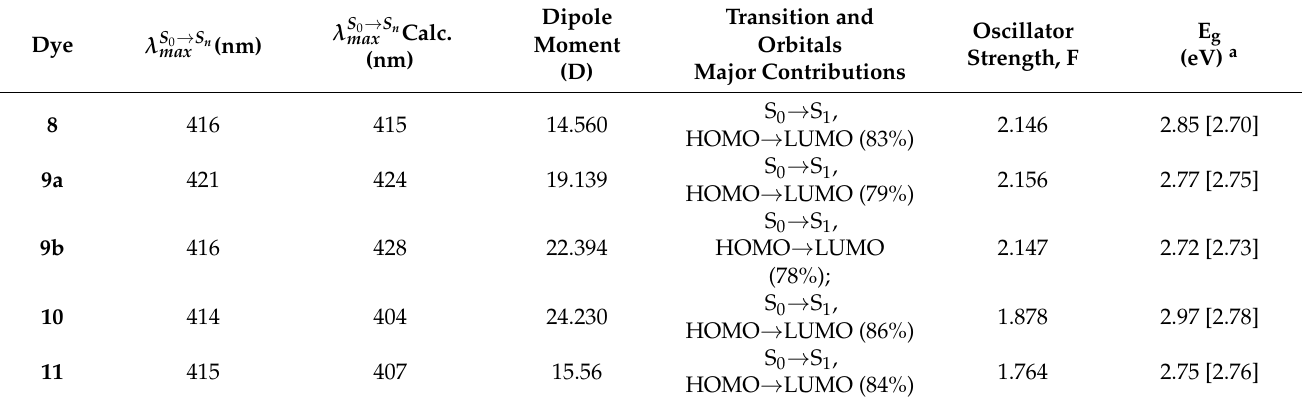
a in brackets the experimental absorption band gap obtained from the intersection between the normalized absorption and fluorescence emission